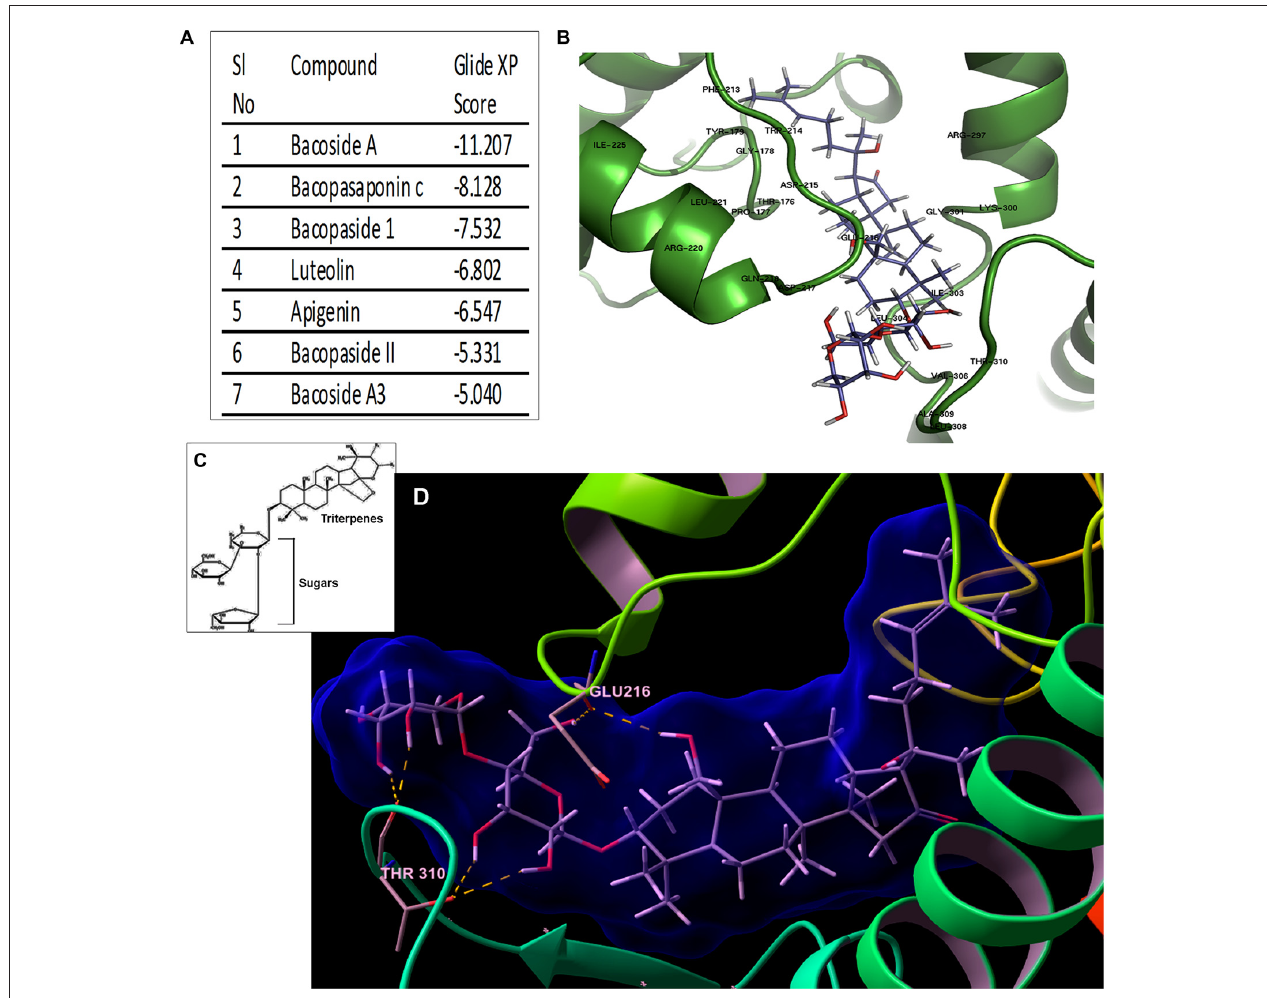
FIGURE 6 | Bacoside A—the bioactive component of BM binds to CaMK2A in silico . (A) Binding affinity (glide score) of different components of the extract of BM to CaMK2A activation domain (200–310 amino acid residues) showed highest glide ratio for Bacoside A which is also the established active component of BM. (B) shows a docked model of CaMK2A-Bacoside A. See Supplementary Figure S6 for docking of other components of BM to CaMK2A. (C) shows the amphipathic molecular structure of Bacoside A constituting hydrophilic glycans and lipophilic terpenoid moieties (D) shows Bacoside A sugar moieties makes hydrogen bonds interactions with CaMK2A protein residues namely Glu216 in the Ser/Thr catalytic domain (13–271 amino acids) and Thr310 in the association domain (293–310 amino acids). Also see Supplementary Figure S7 for more resolved image of the glycan-amino acid interaction in Bacoside A-CaMK2A docked model. Arabinose is observed to interact with Thr310 and Glu216, whereas glucose interacts with Thr310.